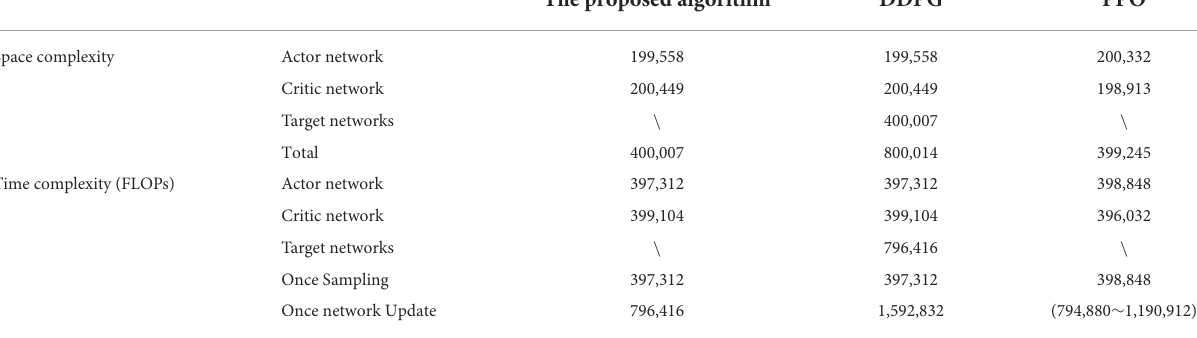
TABLE 1 The space and time complexity